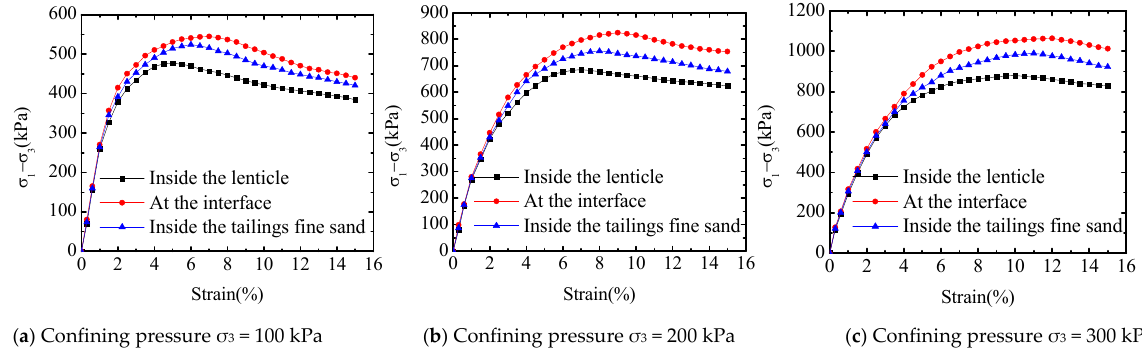
Figure 5. Deviatoric stress ‐ strain curves of reinforced soil in different reinforcement positions, n = 2. (a) Confining pressure σ 3 = 100 kPa, (b) Confining pressure σ 3 = 200 kPa, (c) Confining pressure σ 3 = 300 kPa.